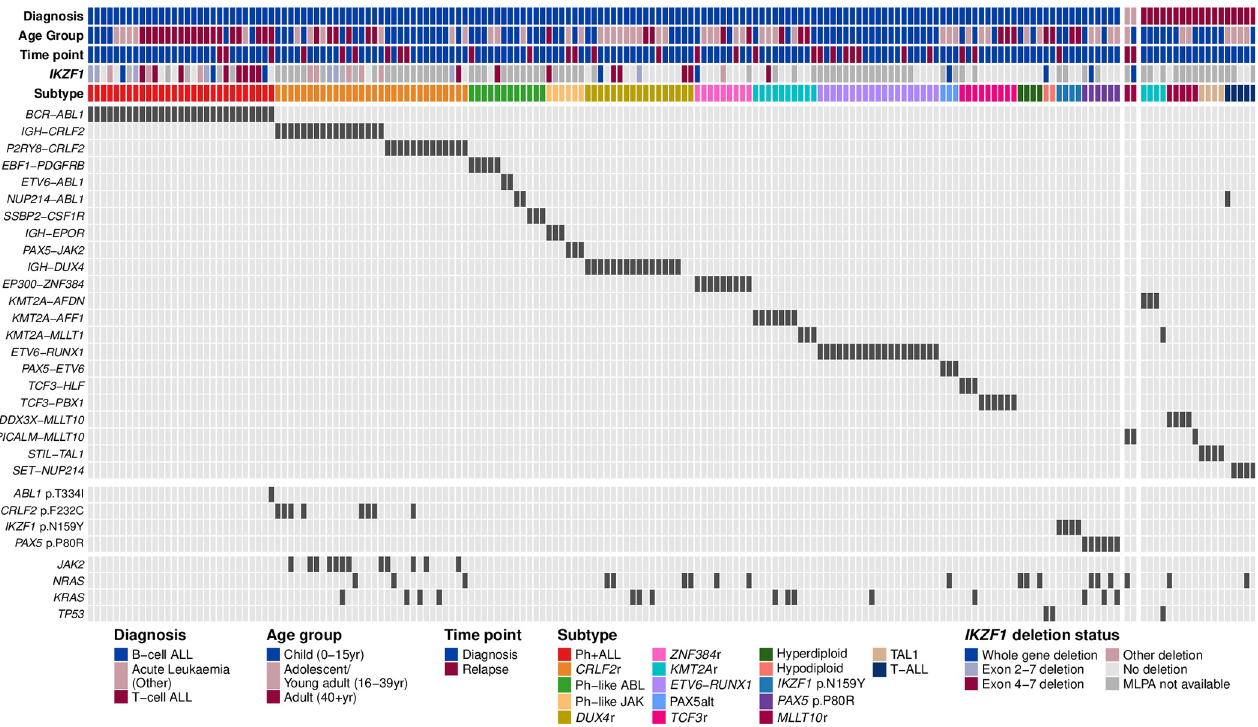
Fig 1. Genomic alterations for patients within the study cohort. Reported genomic alterations for 180 ALL samples analysed by RNA-seq, including 160 B-ALL patient samples (left panel), 18 patients samples classified as T-ALL (right panel), and two samples with acute undifferentiated leukaemia or acute bi- phenotypic leukaemia (middle panel). Each column represents a single patient. Patients were classified into a recognised subtype based on the detected driver mutation. For each patient, the deletion status of IKZF1 , as reported by multiplex ligation-dependent probe amplification, as well as patient diagnosis, age group and sample timepoint are shown and coloured according to the key. Clinically relevant gene fusions detected with RNA-seq are indicated in the middle panel and shown in dark grey. The bottom panel indicates samples for which known pathogenic SNVs were detected by GATK Haplotype caller (shown in dark